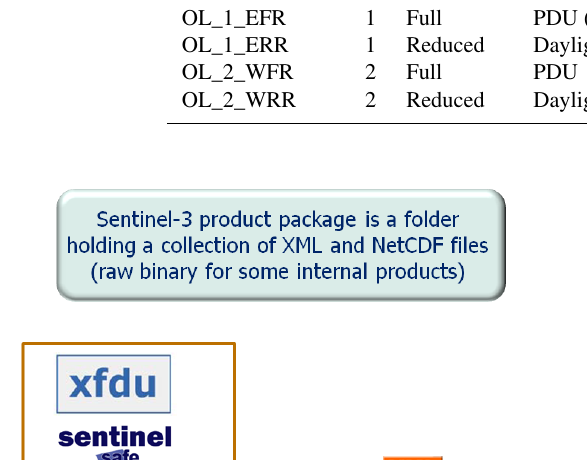
synthetically active radiation over oceans and global cover- age integrated water vapour column. The OLCI level-2 prod- ucts are provided for the global ocean as well as regional seas, as defined in Fig.